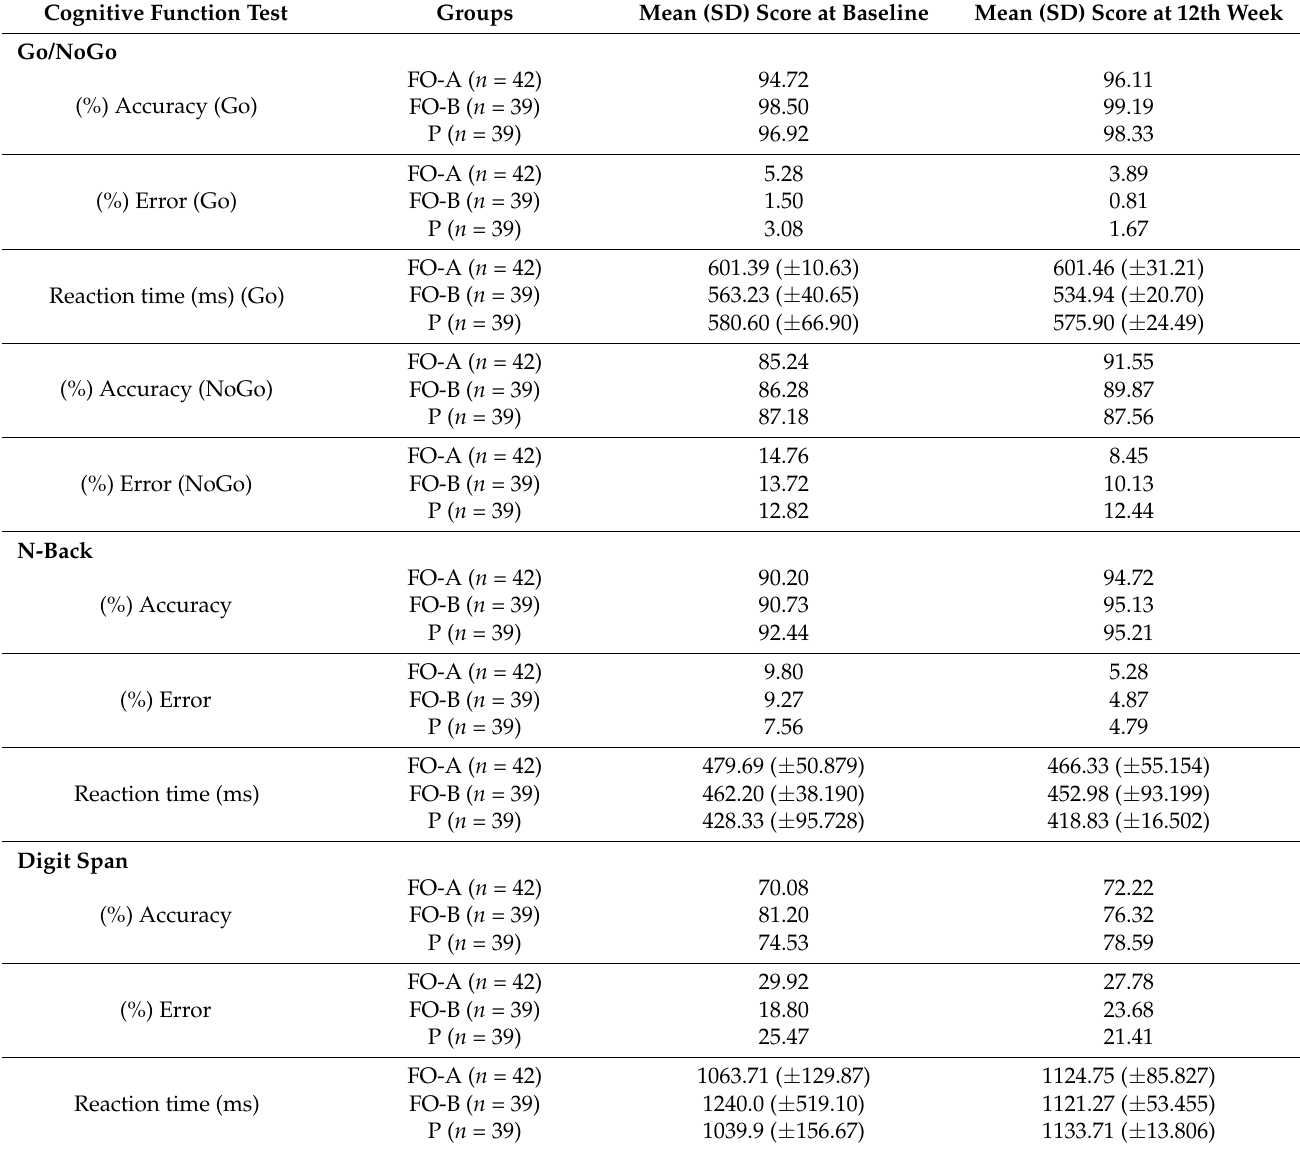
Table 3. The effect of fish oil (FO) on the cognitive function battery test, compared to placebo group. Cognitive Function